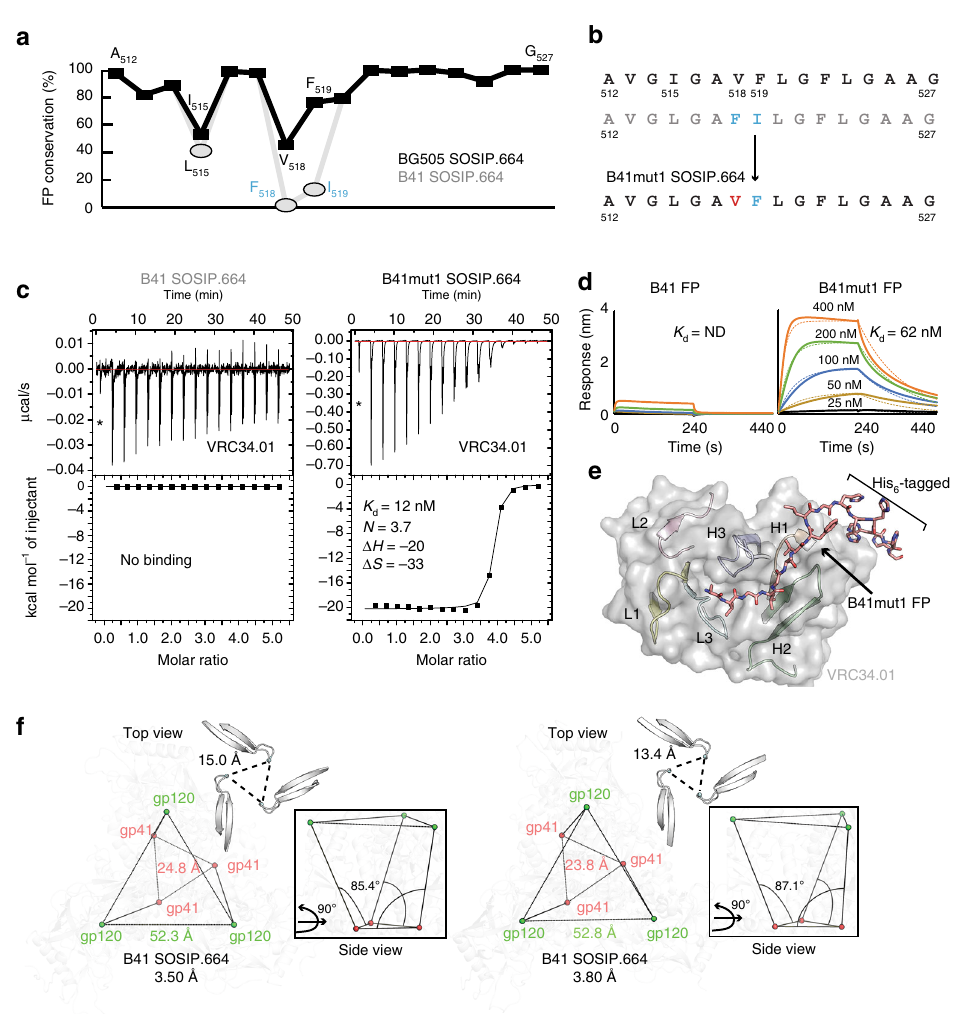
Fig. 3 Restoration of the VRC34.01 epitope on B41 and delineation of Env breathing. a Amino acid conservation of the FP ( X -axis: residues 512 – 527, Y -axis: percent conservation) in BG505 SOSIP.664 (black) and B41 SOSIP.664 (gray). The difference in conservation is shown in rectangles for BG505 SOSIP.664 and ovals for B41 SOSIP.664. For assessing conservation of FP residues, 5451 HIV-1 sequences from Los Alamos National Laboratory (LANL) HIV-1 database were analyzed. b The FP residues of both isolates are aligned to highlight the differences at positions 515, 518, and 519. Construction of the B41mut1 SOSIP.664 is illustrated in the lower panel. c No binding is observed between FP-directed Fab VRC34.01 with wild-type FP of B41 SOSIP.664 (left panel). Restoration of VRC34.01 binding to the mutated B41mut1 SOSIP.664 FP ( K d = 12 nM, three Fabs bind per trimer) is illustrated (right panel). The enthalpy and entropy are measured in kcal per mol and cal per mol per deg, respectively. Data points not included in the fi t are indicated by an asterisk. All binding experiments are measured by ITC and reported values are averages from two independent measurements. d Binding kinetics of B41 FP and FP (mut1) peptide variants of VRC34.01, as determined by BLI. e Crystal structure of His-tagged B41mut1FP peptide bound to VRC34.01. f View down the three-fold trimer apex of B41 SOSIP.664 showing opening and closing of the trimer at 3.50 Å (left) and 3.80 Å (right) resolutions, respectively. Inter-V2 distances (Å; dashed lines) are measured between the C α residues of R166 (cyan). Top views of both crystal structures showing center of mass of each protomer (gp120: green, gp41: red) overlaid on the Env cartoon (light gray) for orientation. Inter-gp41 and inter-gp120 distances (measured in Å; lines) are measured between the center of masses. The insets of the two B41 structures are shown in the side view (right). The angle is measured between center of mass of gp41 and gp120 of a protomer to re fl ect the movement between domains that leads to a slight opening of the